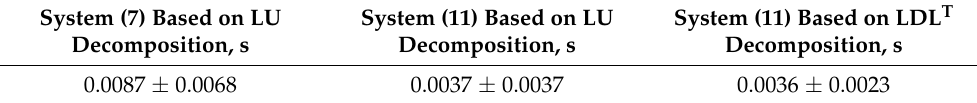
Table 5. The mean values of the decision time and their standard deviations.